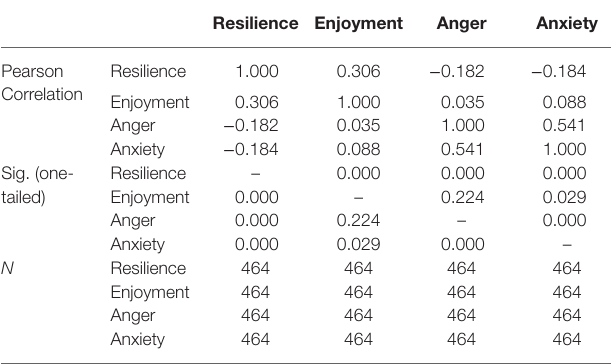
TABLE 2 | Correlations among teachers’ resilience and the components of teachers’ emotions.